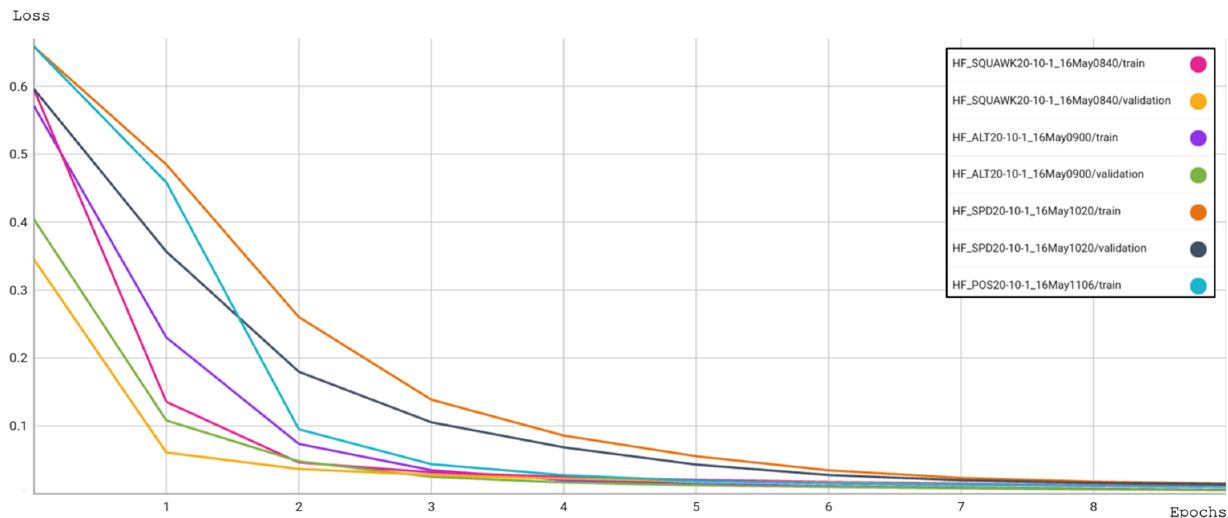
Figure 14. Human factors: model accuracy. Figure 15. Human factors: model